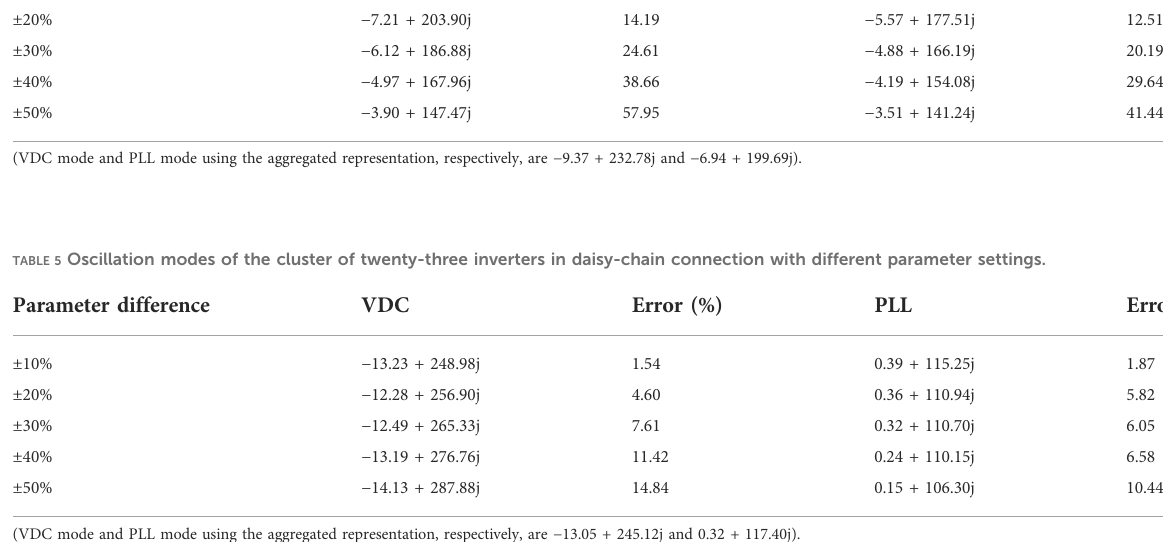
TABLE 4 Oscillation modes of the cluster of fi ve inverters in daisy-chain connection with different parameter settings. Parameter difference